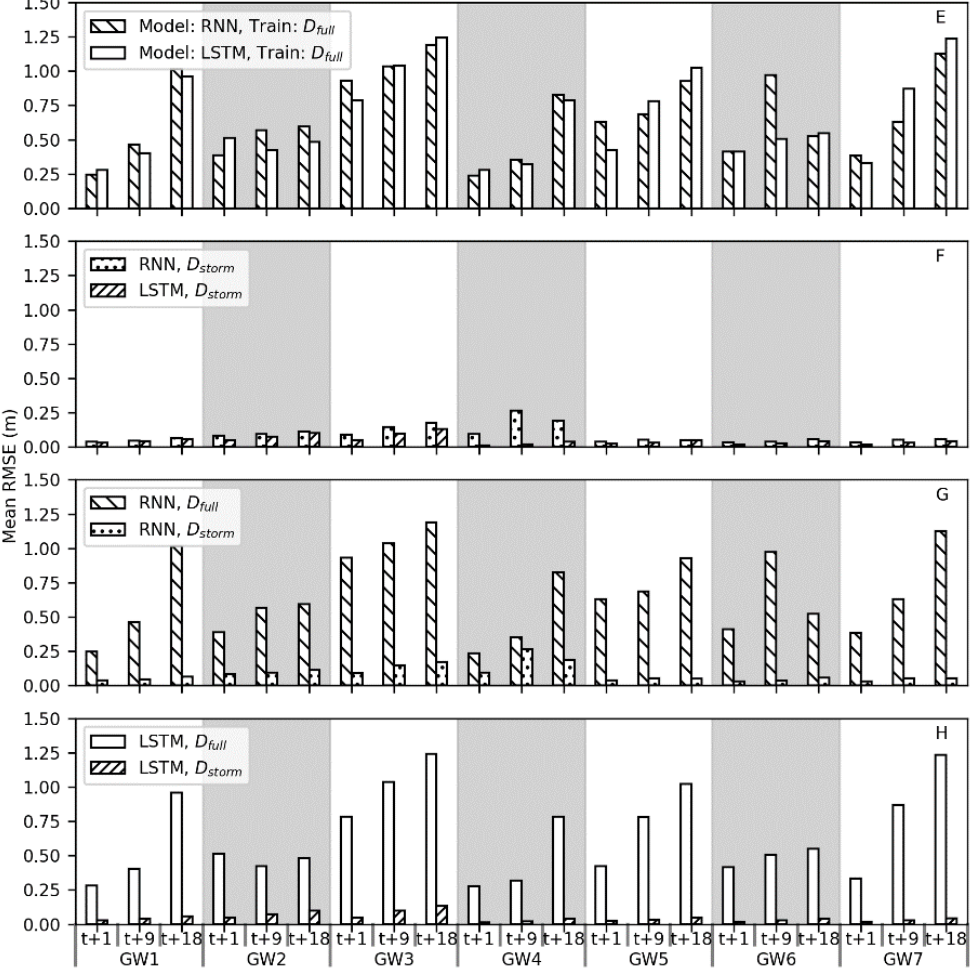
Figure 8. Mean RMSE values from the forecast test set D fcst for each model type and training dataset treatment at each well and forecast period. Subplot letters correspond to the hypothesis being tested (Table 5) and are comparisons of ( E ) RNN and LSTM models trained with D full ( F ) RNN and LSTM models trained with D storm ( G ) RNN models trained with either D full or D storm ( H ) LSTM models trained with either D full or D storm .